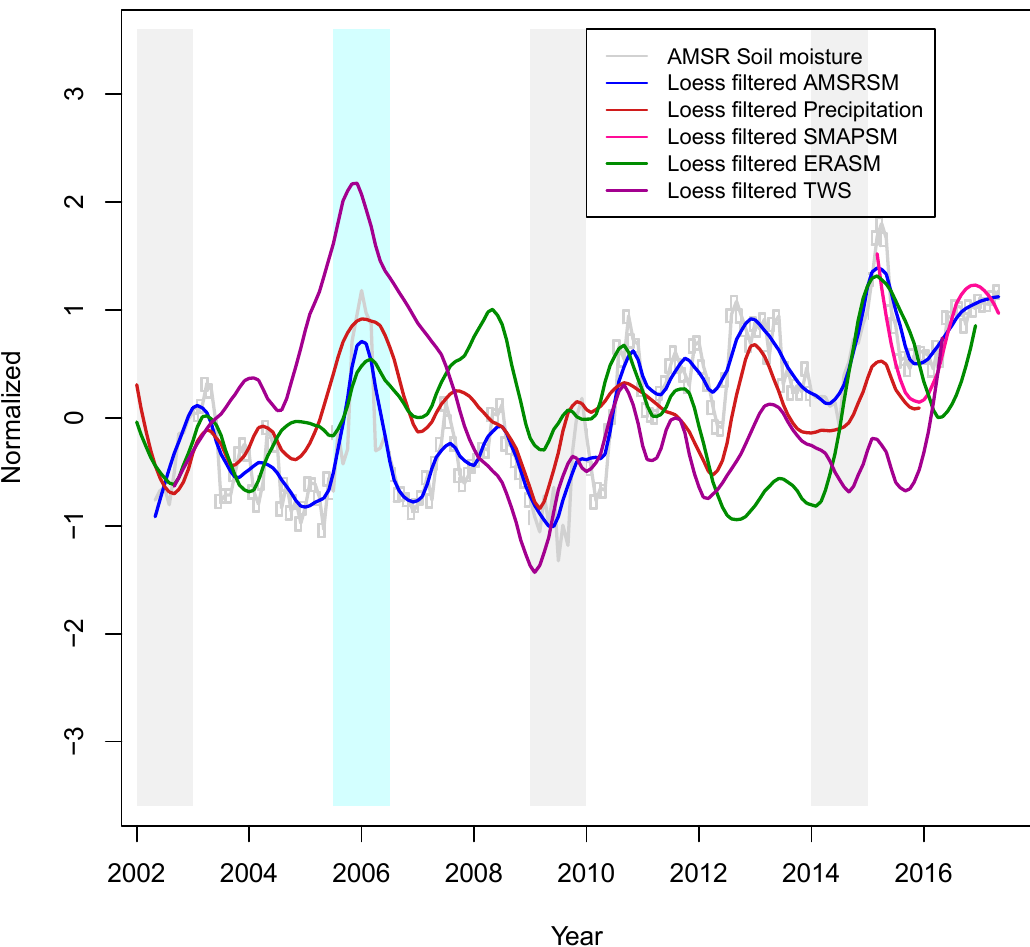
Figure 3. Time series (normalized units) of soil moisture (AMSR, SMAP, and ERA), precipitation (IMD), and total water storage (GRACE) in India. The vertical gray bars indicate drought periods and the light blue bar represents a period of excess of water.